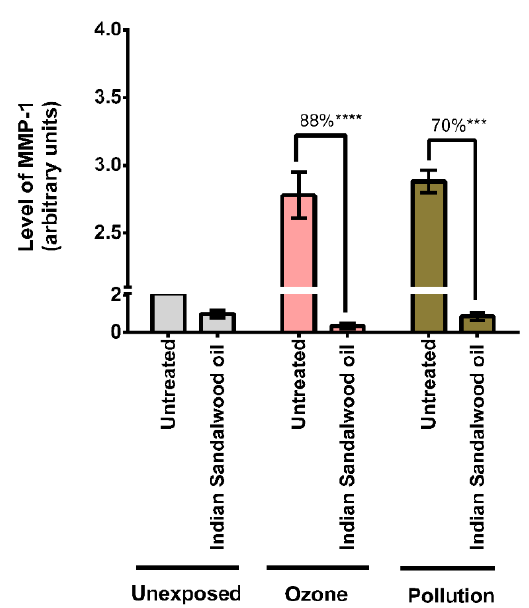
Figure 5. Assessment of the level of MMP-1 after exposure of human skin explants to different environmental conditions. The graph represents the ability of the Indian sandalwood oil to prevent the secretion of MMP-1 after being exposed to various environmental stressors. The skin explants were exposed to cigarette smoke (30 min) and ozone (30 min). The supernatant was collected 24 h after exposure and was assayed for MMP-1. This assay was performed in triplicate. *** represents p value < 0.001; **** represents p value < 0.0001.